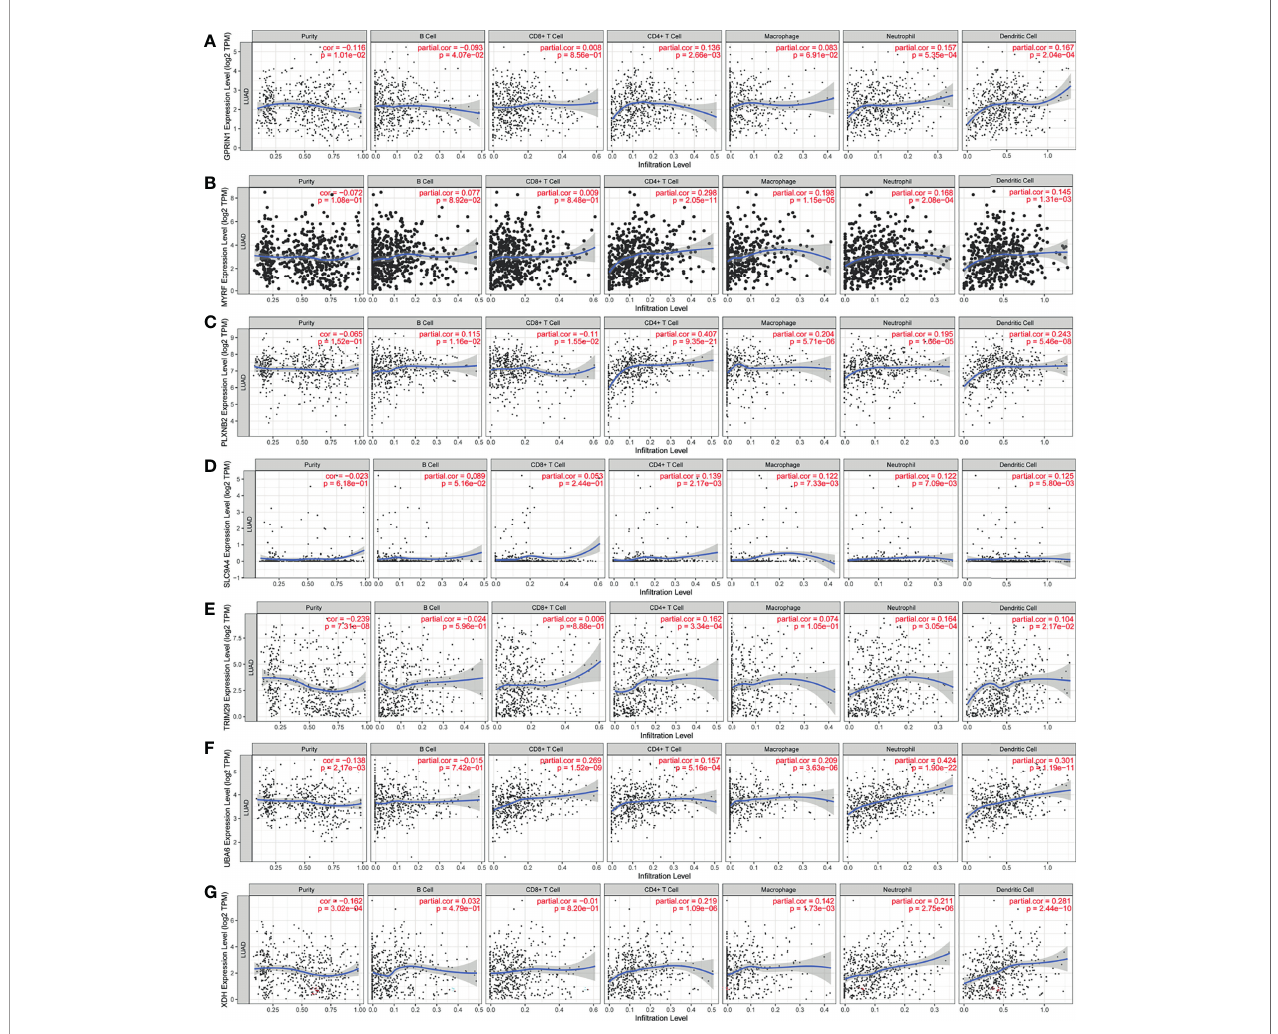
FIGURE 3 | The validation of LUAD-related immune biomarkers by predicting immune-in fi ltrating cells. The correlation between gene expression of GPRIN1 (A) , MYRF (B) , PLXNB2 (C) , SLC9A4 (D) , TRIM29 (E) , UBA6 (F) , XDH (G) , and the in fi ltration of B cells, CD8 + T cells, CD4 + T cells, macrophages, neutrophils and DCs in